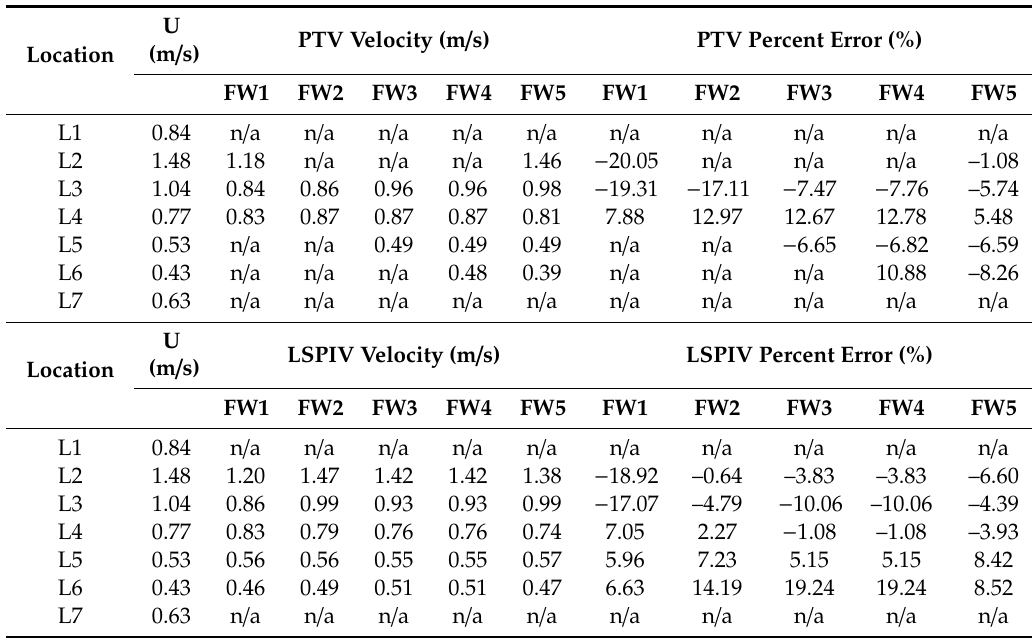
Table A2. PTV and LSPIV results for each location compared to reference measurements on the Bradano River.